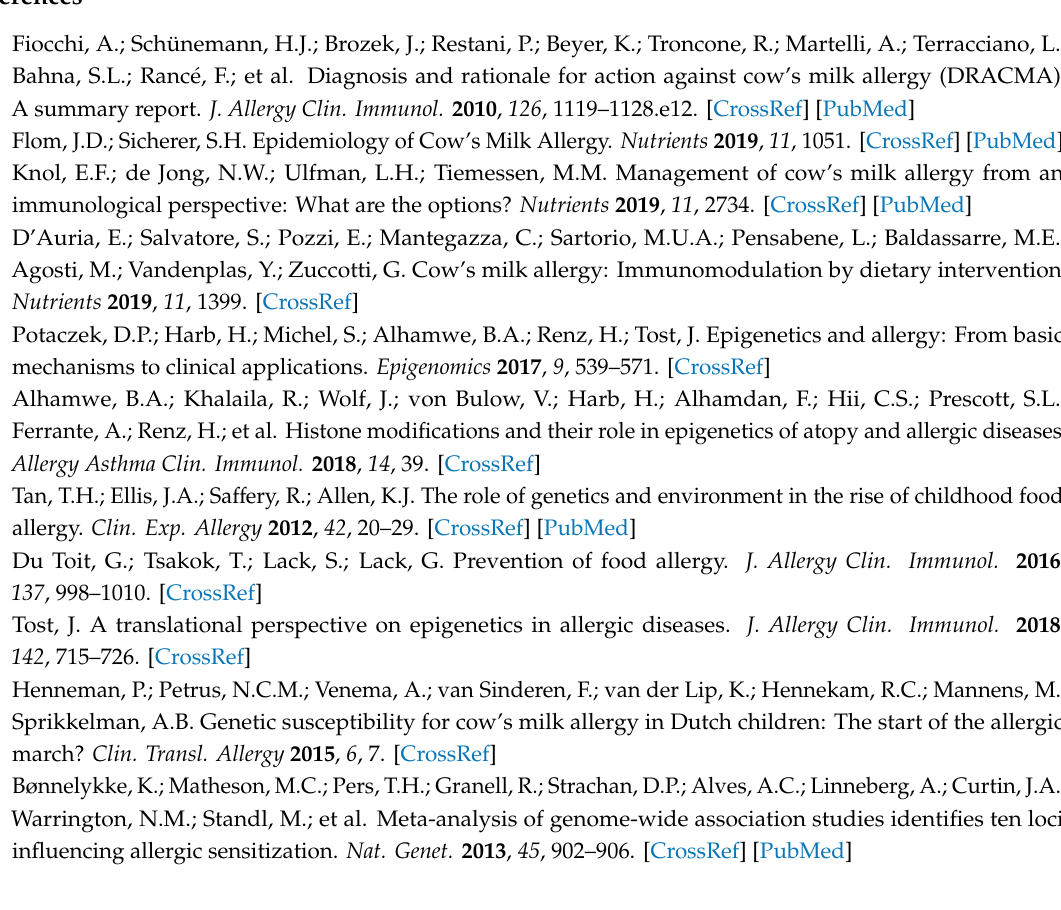
Table S1: Bu ff ers used for ChIP, Table S2: Primers used for qPCR, Figure S1: A confirmed allergic response to whey protein increased the ratio of histone acetylation levels at the gene encoding Gata3 ( Gata3 ) and the gene encoding T-box 21 ( Tbx21 ) in spleen-derived CD4 + T